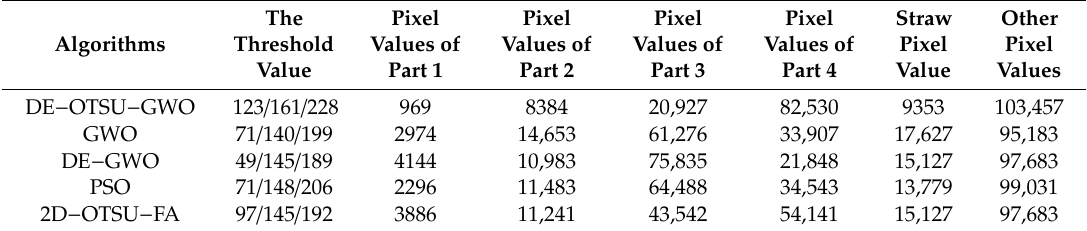
Table 7. The segmentation results of five algorithms.